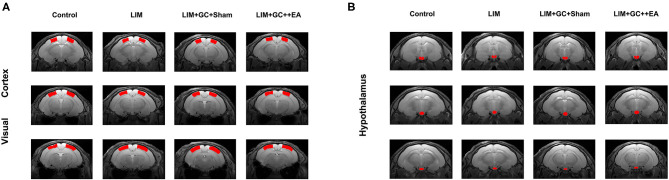
Anatomical locations of the visual cortex ROI (A), based on Paxinos et al., 1980. Anatomical locations of the hypothalamus ROI (B), based on Papp et al., 2014 [control (n = 6), LIM (n = 5), LIM+GC+Sham (n = 4), and LIM+GC+EA (n = 6)].